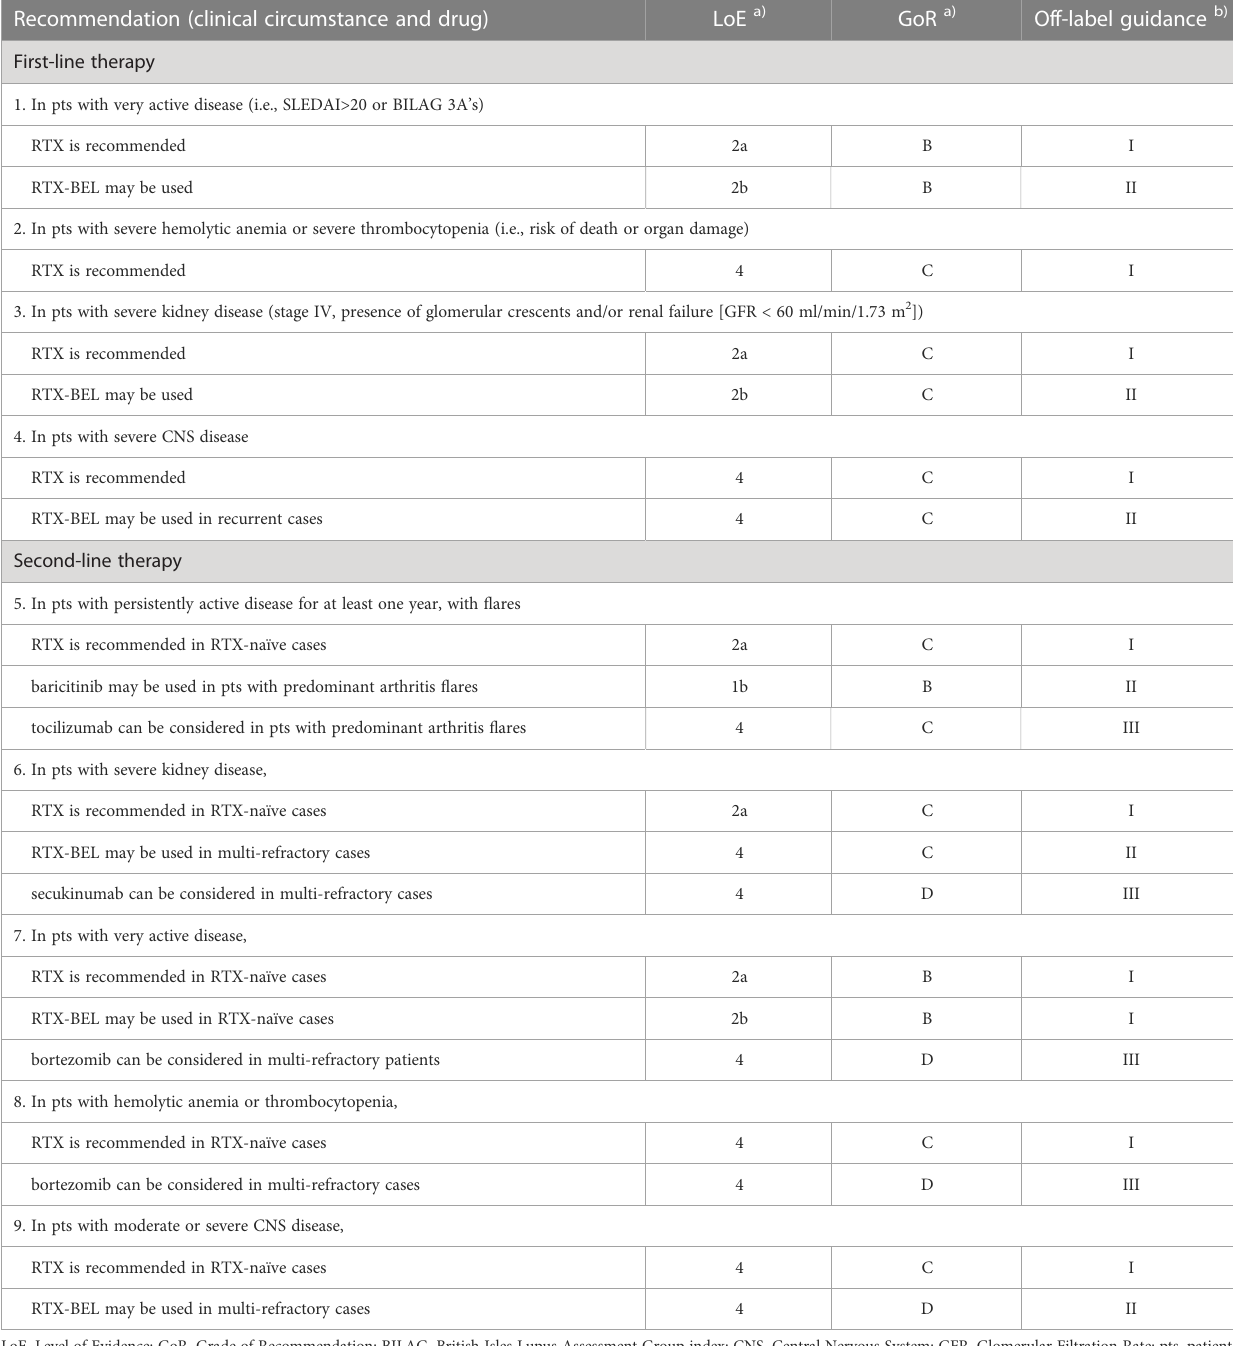
TABLE 2 Recommendations for off-label biologic therapy of systemic lupus erythematosus. Recommendation (clinical circumstance and